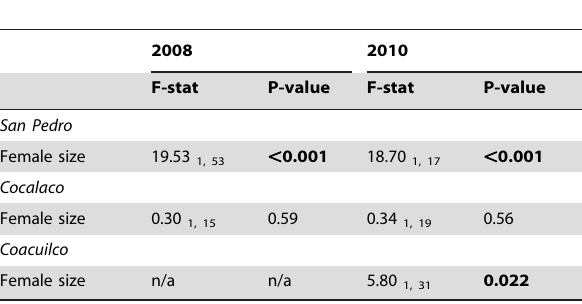
Table 1. Offspring size as a function of female size for each site in each year.